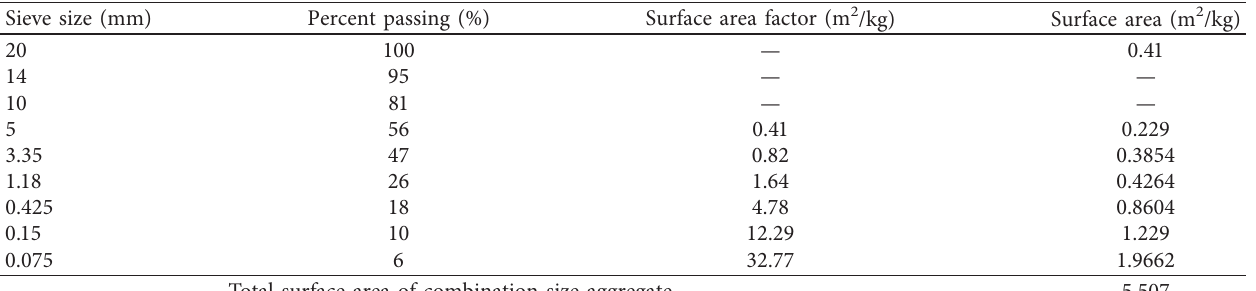
Table 6: The determination of surface area.